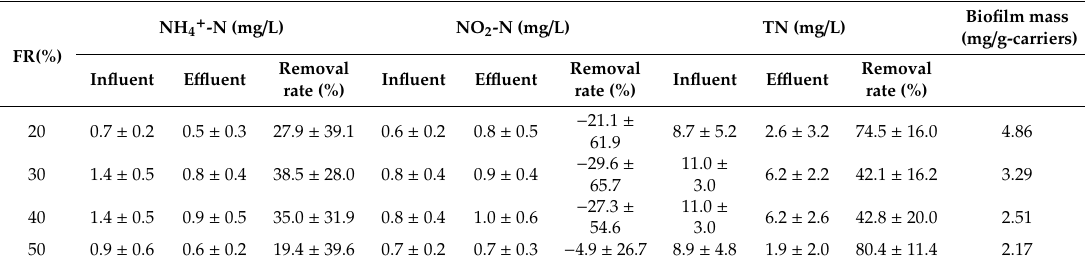
Table 2. NH 4+ -N, NO 2- -N, and TN removal efficiency and biofilm mass of denitrifying MBBR at different FRs. Table 2. NH 4 + -N, NO 2 − -N, and TN removal e ffi ciency and biofilm mass of denitrifying MBBR at di ff erent FRs.